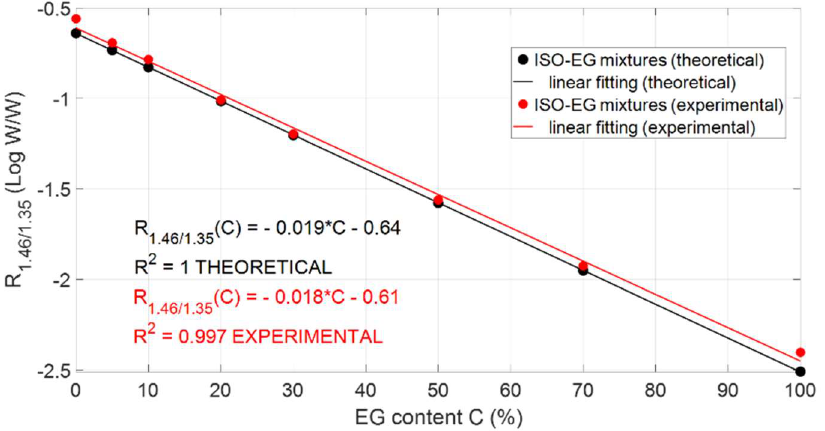
Figure 7. Experimental and theoretical responsivity data points (red and black dots, respectively) with best linear fittings.